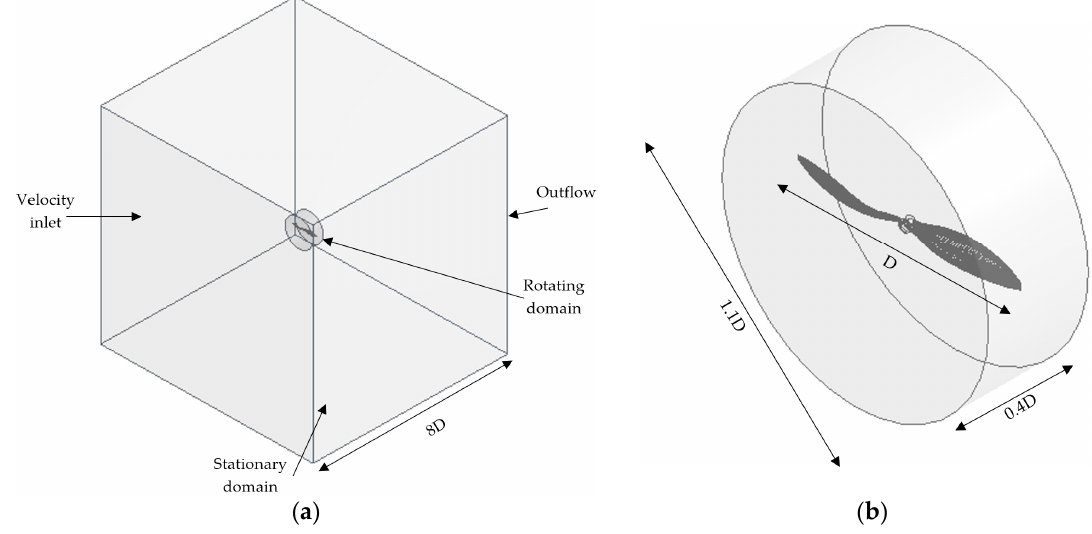
Figure 2. Flow domain and boundary conditions. ( a ) Stationary domain and boundary conditions. The boundary conditions include an inlet, outlet, stationary domain, and rotating domain; ( b ) Rotating domain.